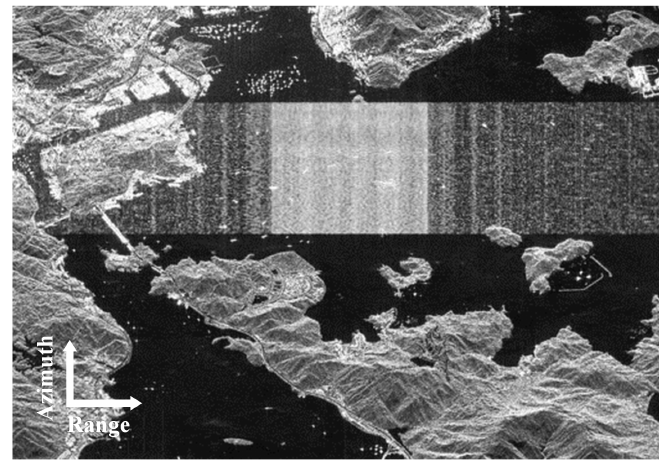
Figure 9. Jamming result of the designed NLFM waveform. Table 2. Contrast and entropy to evaluate jamming